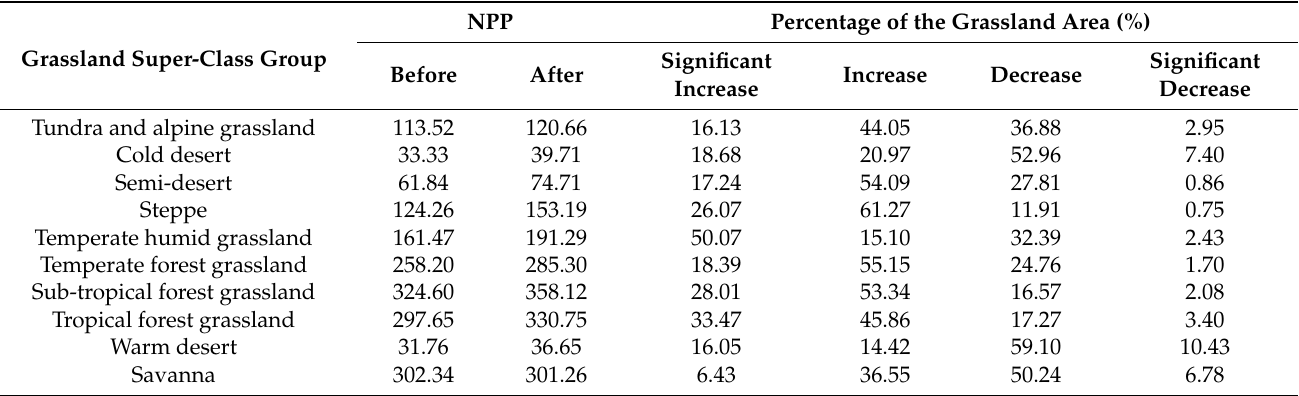
Table 1. The statistical description for the average NPP (g C m − 2 a − 1 ) among grassland super-class